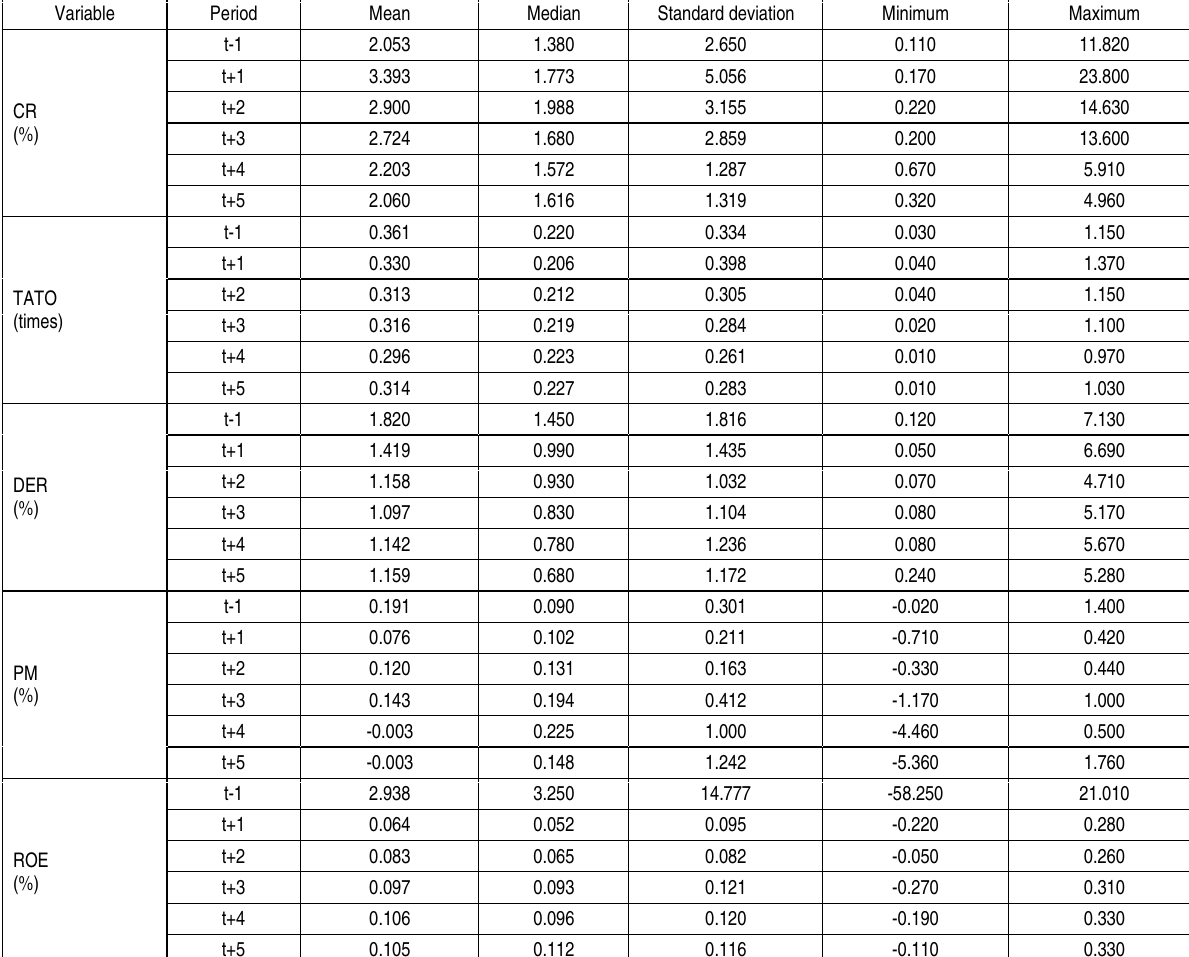
Table 1. Statistic descriptive of